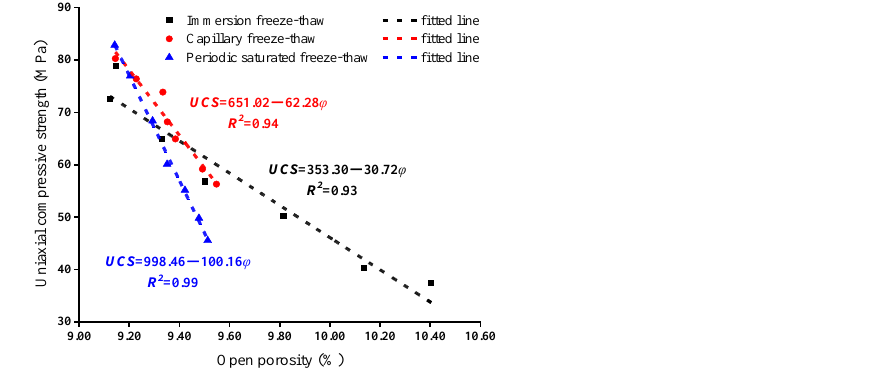
Figure 16. Correlation curve between open porosity and UCS of rock samples.